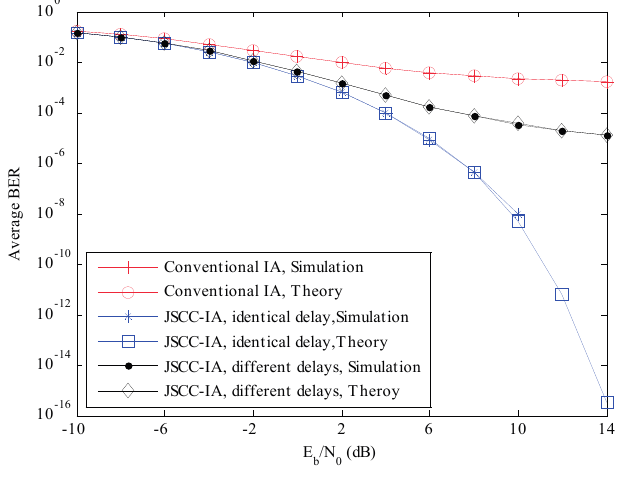
Figure 4. The average theoretical and experimental BER performances of the conventional IA scheme and the JSCC-IA schemes with identical/different propagation delays in the (4 × 4, 1) 10 symmetric